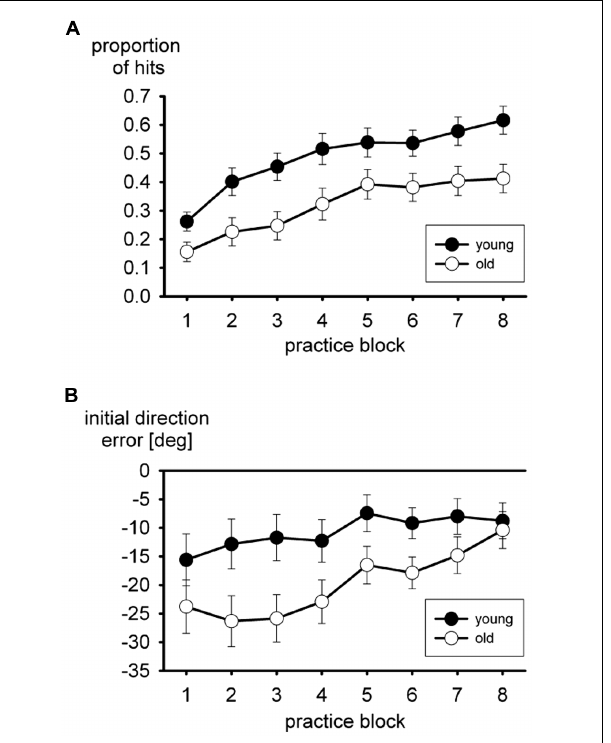
FIGURE 1 | Mean proportion of hits (A), and mean initial direction errors (B) during practice of the virtual putting task. Error bars mark standard errors of the